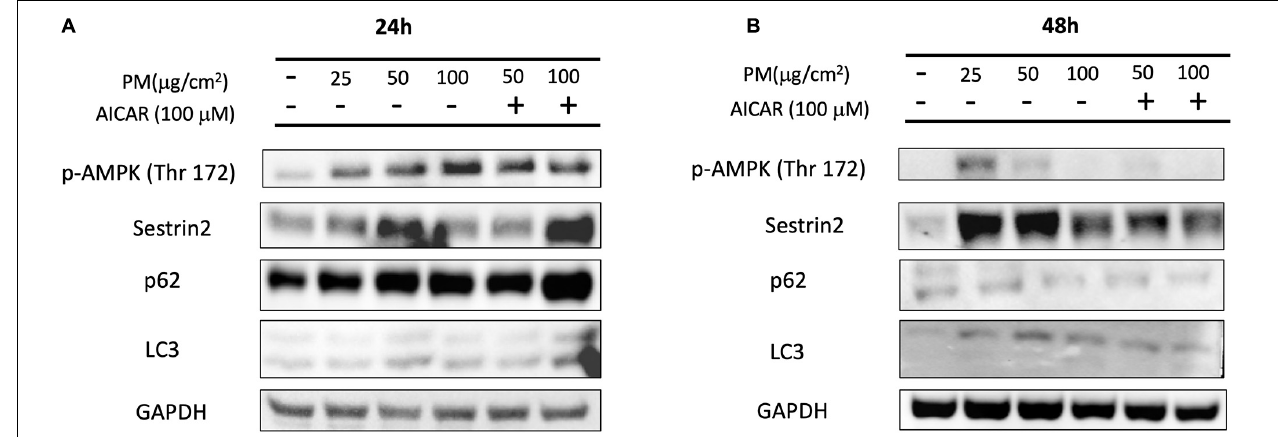
FIGURE 3 | Effect of PM exposure and AICAR on AMPK-Sestrin2 protein expression in A549 cells. (A) Representative western blot images of p-AMPK (Thr 172), Sestrin2, p62, and LC3 at (A) 24 h and (B) 48 h of PM exposure and AICAR